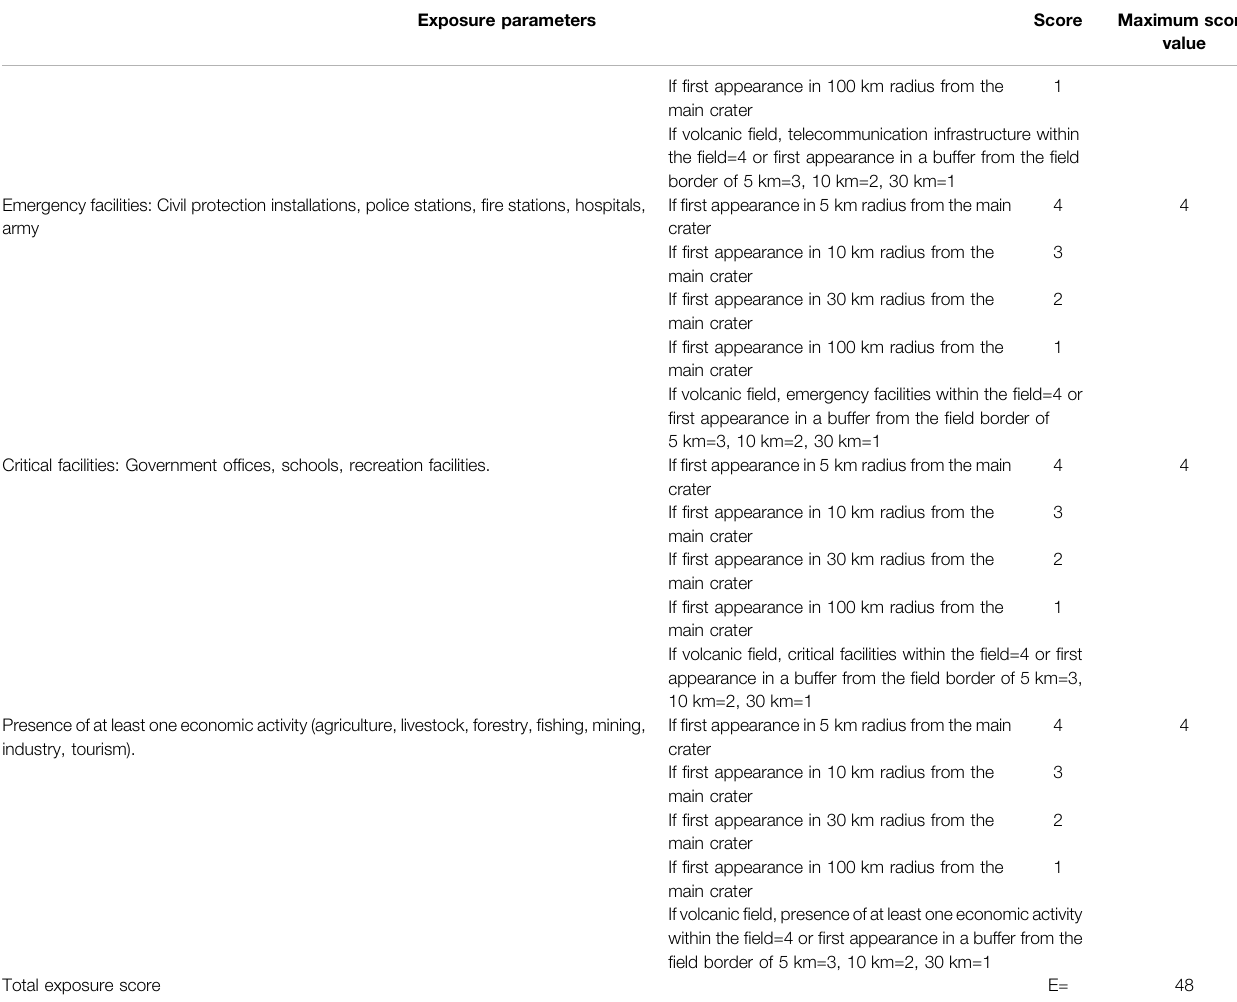
TABLE 2 | ( Continued ) Exposure parameters evaluated in the new ranking strategy (adapted from Ewert et al. (2005)). Exposure parameters